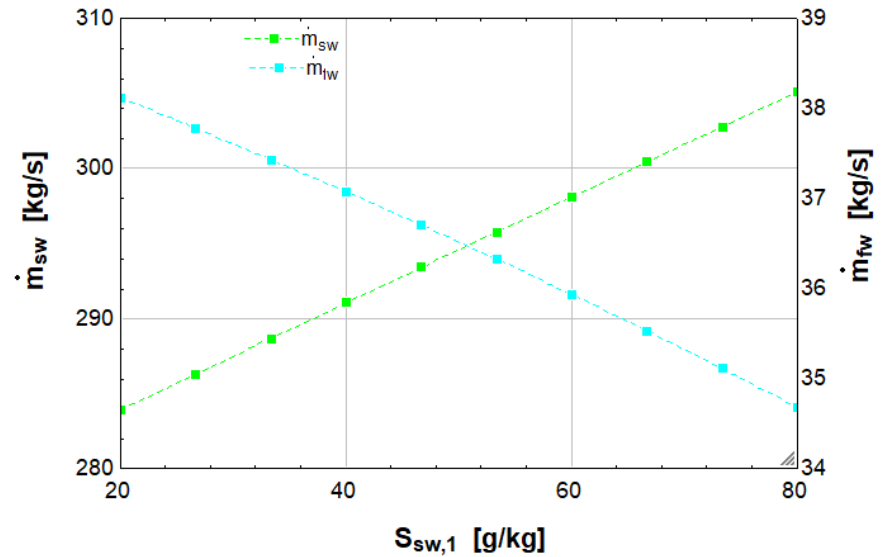
Figure 8. Effect of Salinity on Fresh Water and Sea Water Production .